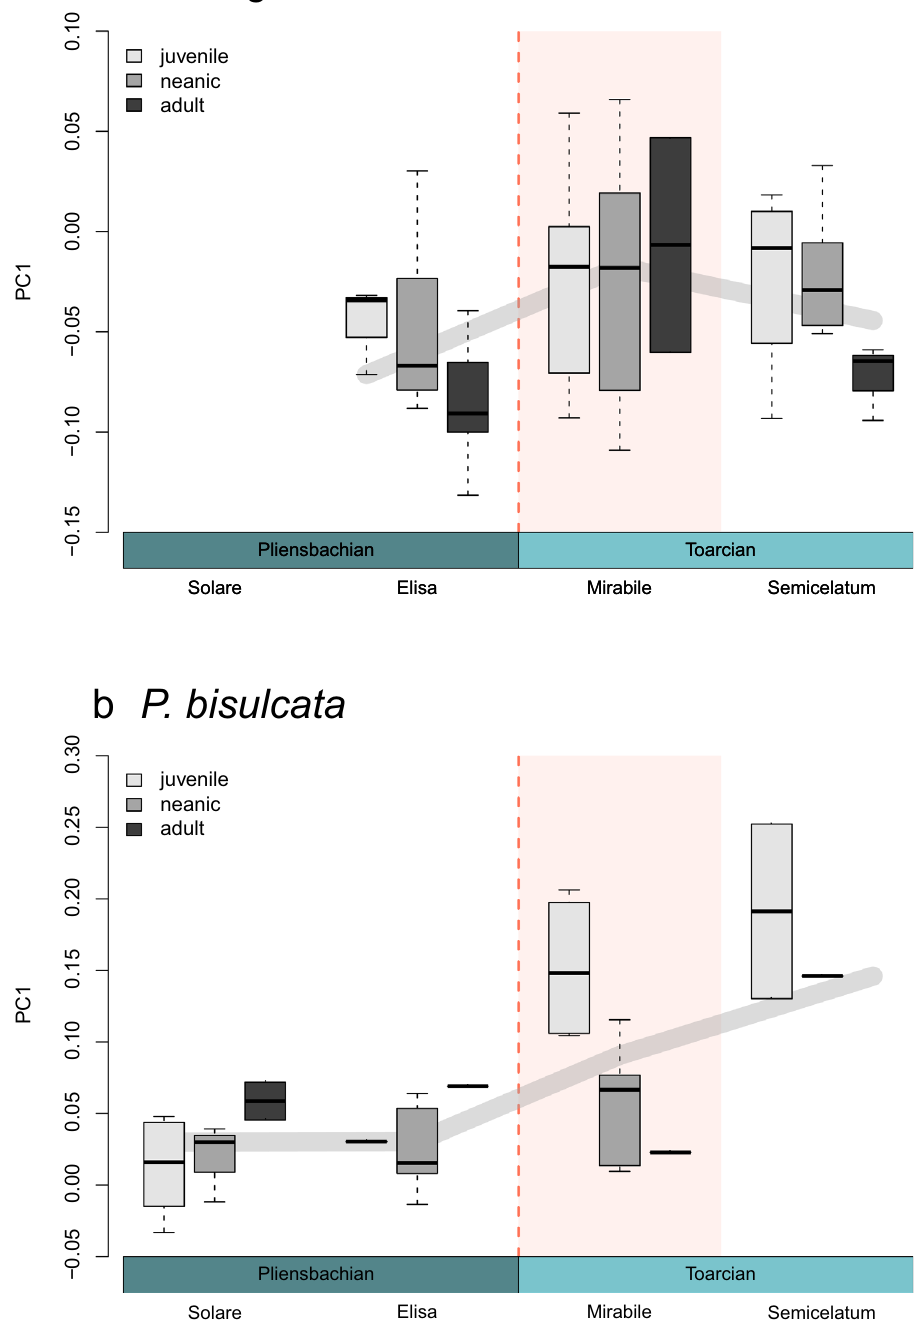
Figure 4. Robustness (PC1) of ( a ) C. longiforma and ( b ) P. bisulcata life stages by subzone. The thick grey lines indicate the overall robustness, while the overlaying boxplots are split by ontogenetic stage (left to right: juvenile (light grey), neanic (medium grey), adult (dark grey)). The red background in the first Toarcian subzone (Mirabile) indicates the hyperthermal stress from the PToB event. (see sample sizes in Table